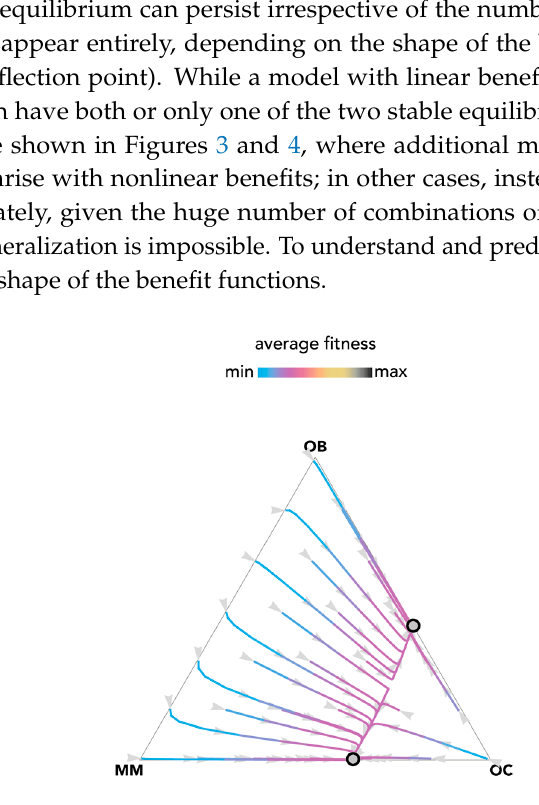
Figure 1. Bistability with linear benefits. The distance from each vertex is inversely proportional to the frequency of each type. Arrows show the direction of the dynamics; colors show the average fitness of the population. N = 10; c OC = 0.1; c OB = 0.2; c MM = 0.3; B OC,OC = 0; B OC,OB = 1; B OC,MM = 1.1; B OB,OC = 1; B OB,OB = 0; B OB,MM = 0; B MM,OC = 1.1; B MM,OB = − 0.3; B MM,MM = 0; s i,j → 0.